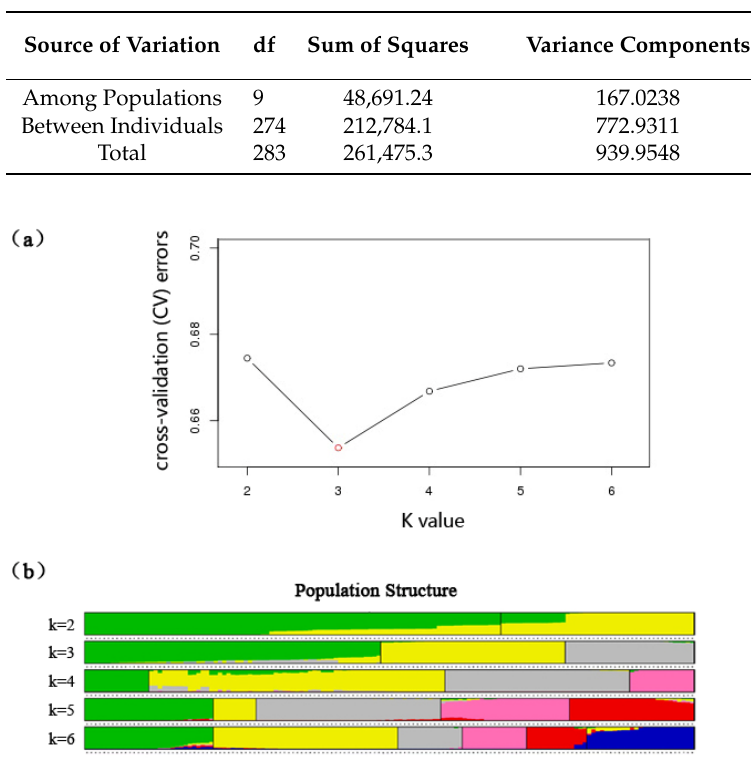
Figure 2. Rational group number and population structure of Chosenia arbutifolia . ( a ) The optimal K value estimated via Admixture; ( b ) Population structure for the 142 Chosenia arbutifolia individuals. The green, yellow, and gray colors represent group 1, group 2, and group 3 when K = 3,